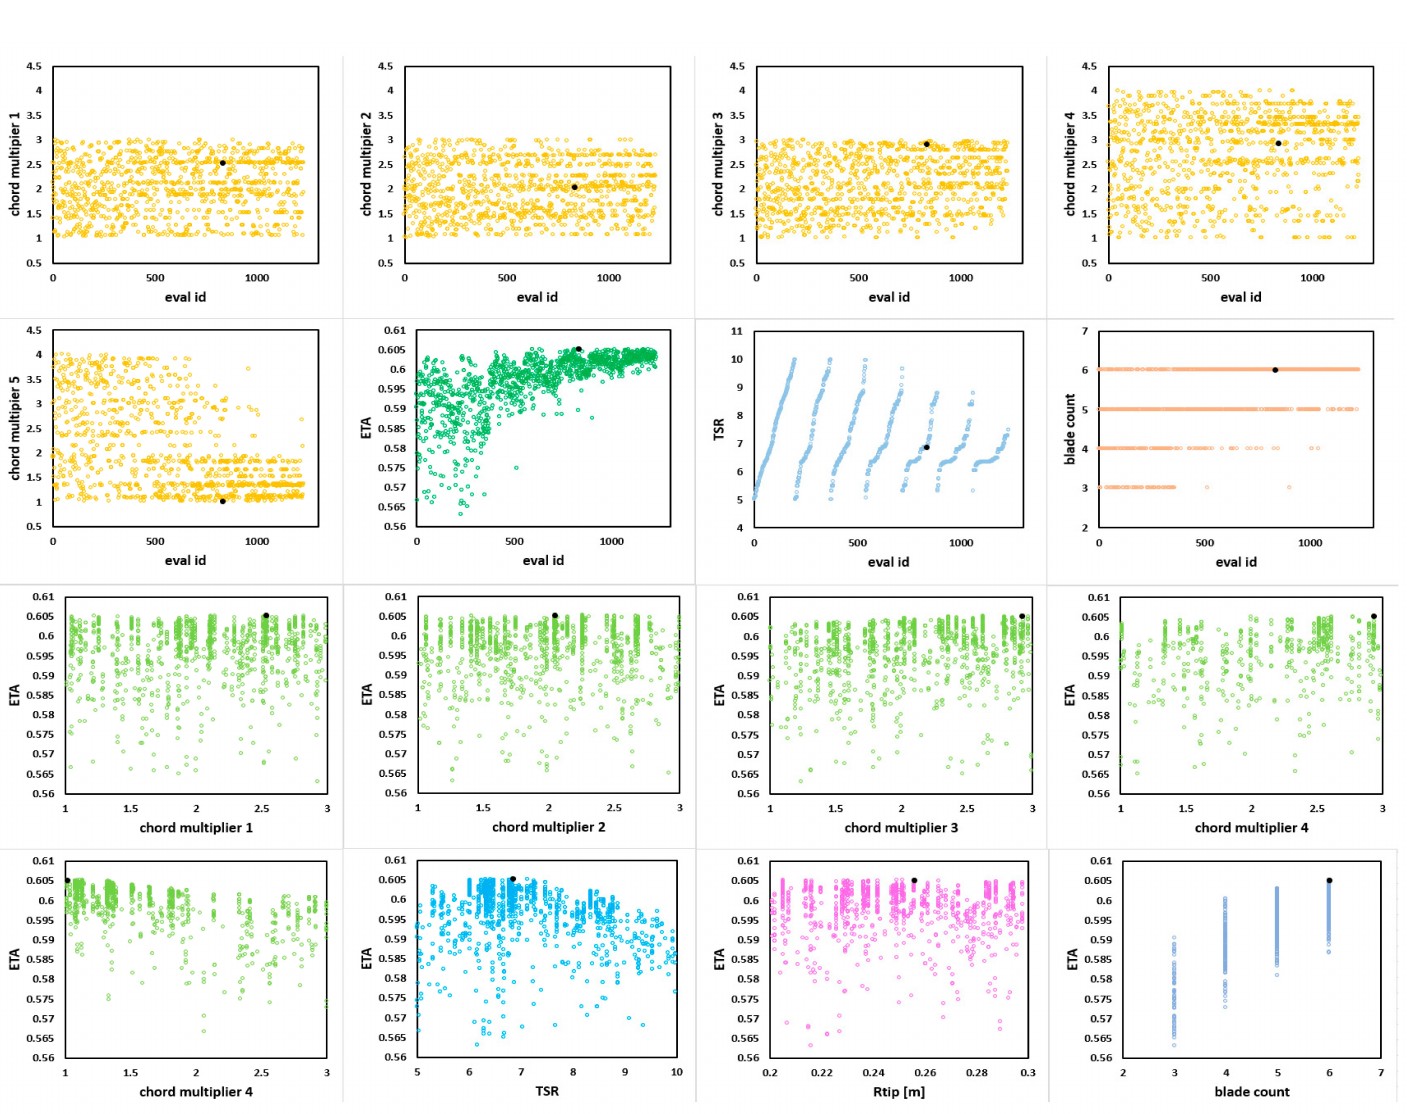
Figure 37. Several parameters in each HKT evaluation, with the optimum value plotted as black